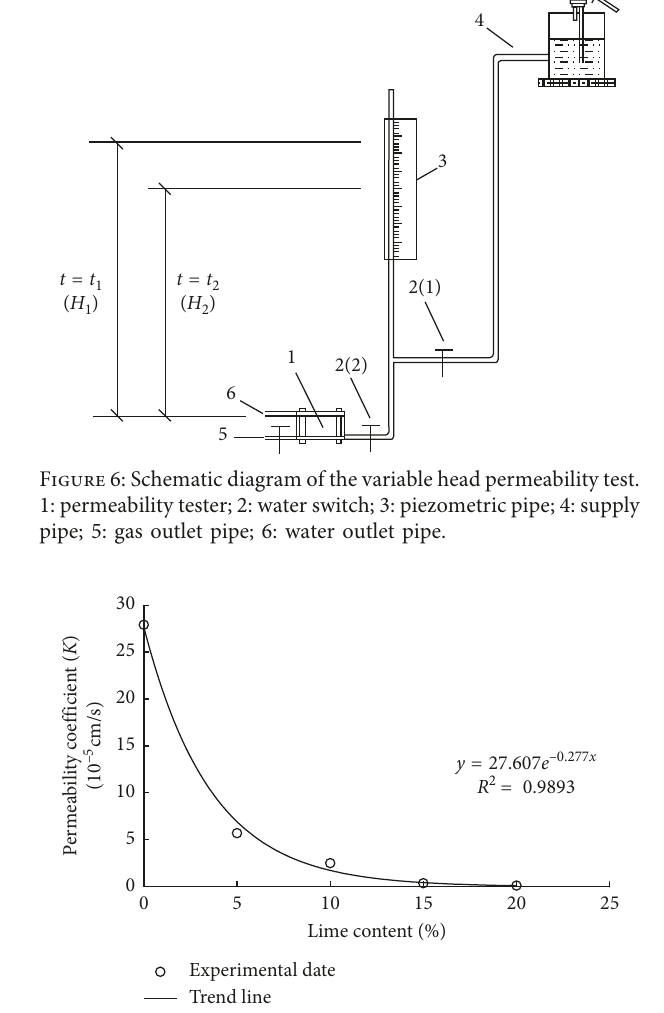
Figure 7: The relationship curve of permeability and lime content.